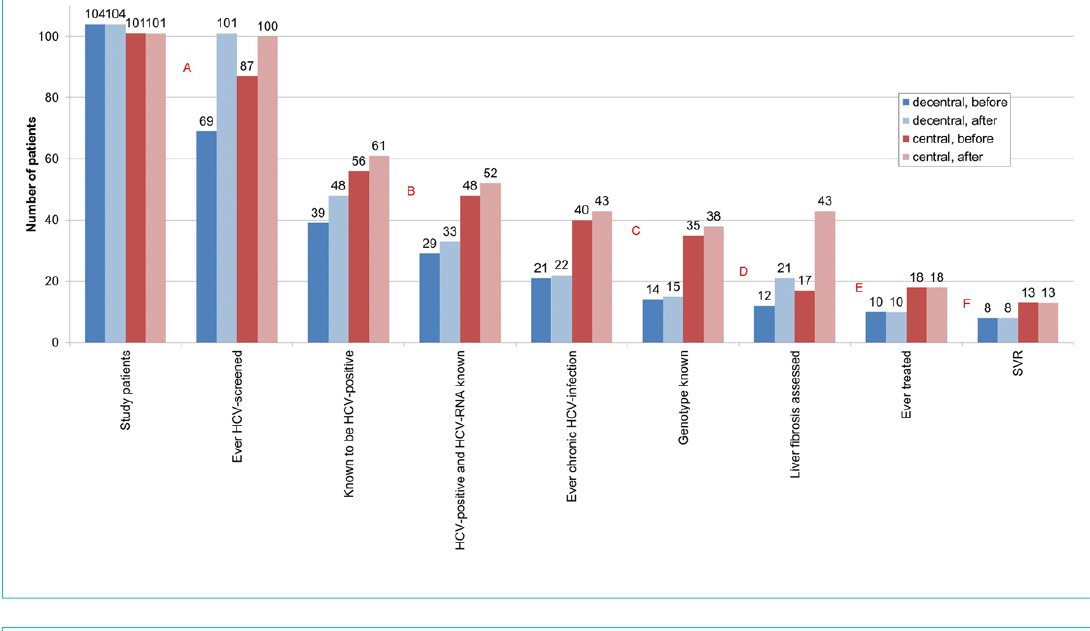
Figure 4: HCV cascade according to place of recruitment (decentralised versus centralised setting), before and after HCV rapid tests and Fi- broscan ® within our study.HCV = hepatitis C virus; SVR = sustained virological response; before = before HCV rapid tests and Fibroscan ® within our study; after = after HCV rapid tests and Fibroscan ® within our studyA = first diagnostic gap – no HCV antibody screening: 33.7% (35/104) vs 13.9% (14/101) (p<0.001) → 2.9% (3/104) vs 1.0% (1/101) (p=0.327); B = second diagnostic gap – no HCV RNA determination, if HCV positive: 25.6% (10/39) vs 14.3% (8/56) (p = 0.165) → 31.3% (15/48) vs 14.8% (9/61) (p=0.039); C = third diagnostic gap – HCV geno- type unknown, if ever chronic HCV infection: 33.3% (7/21) vs 12.5% (5/40) (p=0.052) → 31.8% (7/22) vs 11.6% (5/43) (p=0.047); D = fourth di- agnostic gap – no liver fibrosis assessment, if ever chronic HCV infection: 42.9% (9/21) vs 57.5% (23/40) (p = 0.277) → 4.5% (1/22) vs 0.0% (0/43) (p = 0.159). E = treatment uptake gap – never treated, if ever chronic HCV infection: 52.4% (11/21) vs 55.0% (22/40) (p = 0.845) →